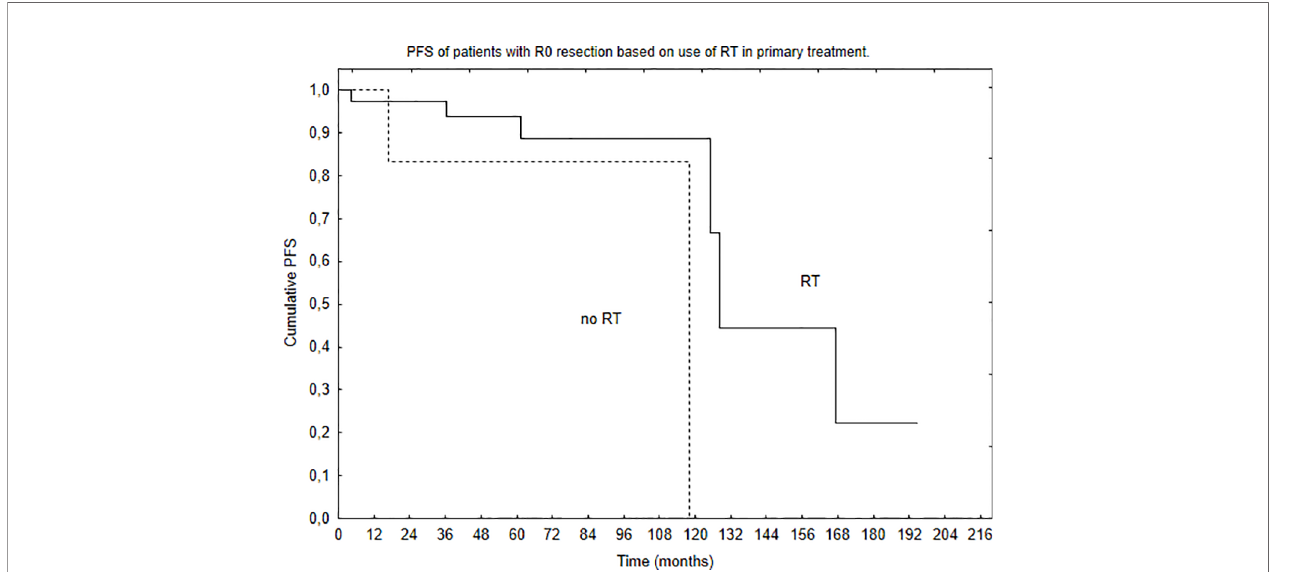
FIGURE 4 | Progression-free survival of patients with GTR (R0 resection) of the tumor based on the use of RT in primary treatment ( p = 0.29).